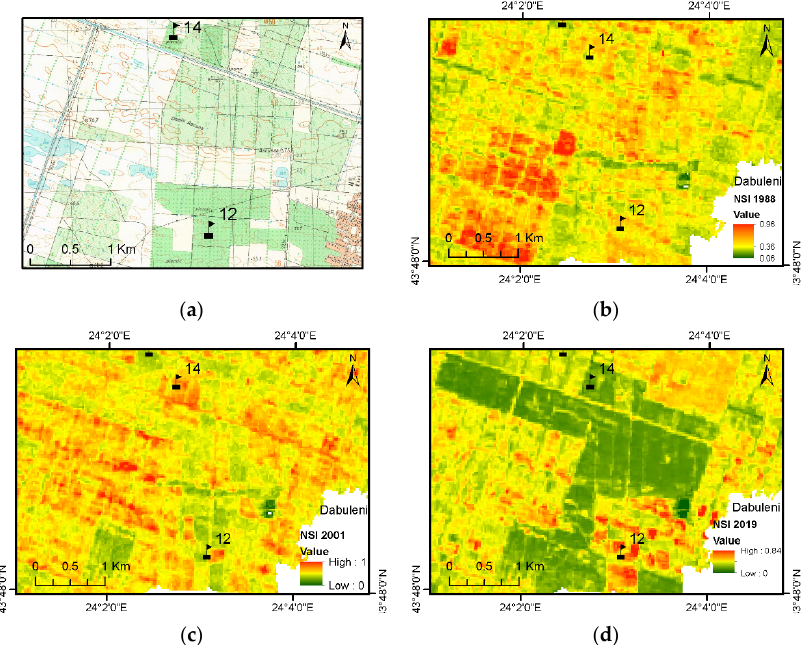
Figure 8. Orchards ( a ) replaced by farmland and compact forest in the vicinity of profiles 12 and 14 ( b – d ). With the levelling of the relief, the lakes between the dunes (Figure 8a) disappeared, leading to the expansion of the uncovered sandy areas (Figure 8b). The mitigation of hot areas was achieved by the expansion of compact forests (Figure 8d, Table 8), with the rate of reforestation in SW Oltenia being higher than the rate of deforestation [77], at least in some periods. In the central and southern part, linear dunes are more clearly expressed in the relief than in the north, their characteristics being parallelism, regular spacing, and partial vegetation [78]. The dune peaks, in the shape of an arrow, intersect with the rectangular surface of the farmland, penetrating the Chernozems area (Figure 9a). The change in colour of the A horizon over a distance of several meters marks the transition from Arenosols to Chernozems (Table 7). The agricultural use of dune soils keeps the peak active, but agricultural work and wildlife in Chernozems limit the correct estimate of peak dynamics (Figure 9d).